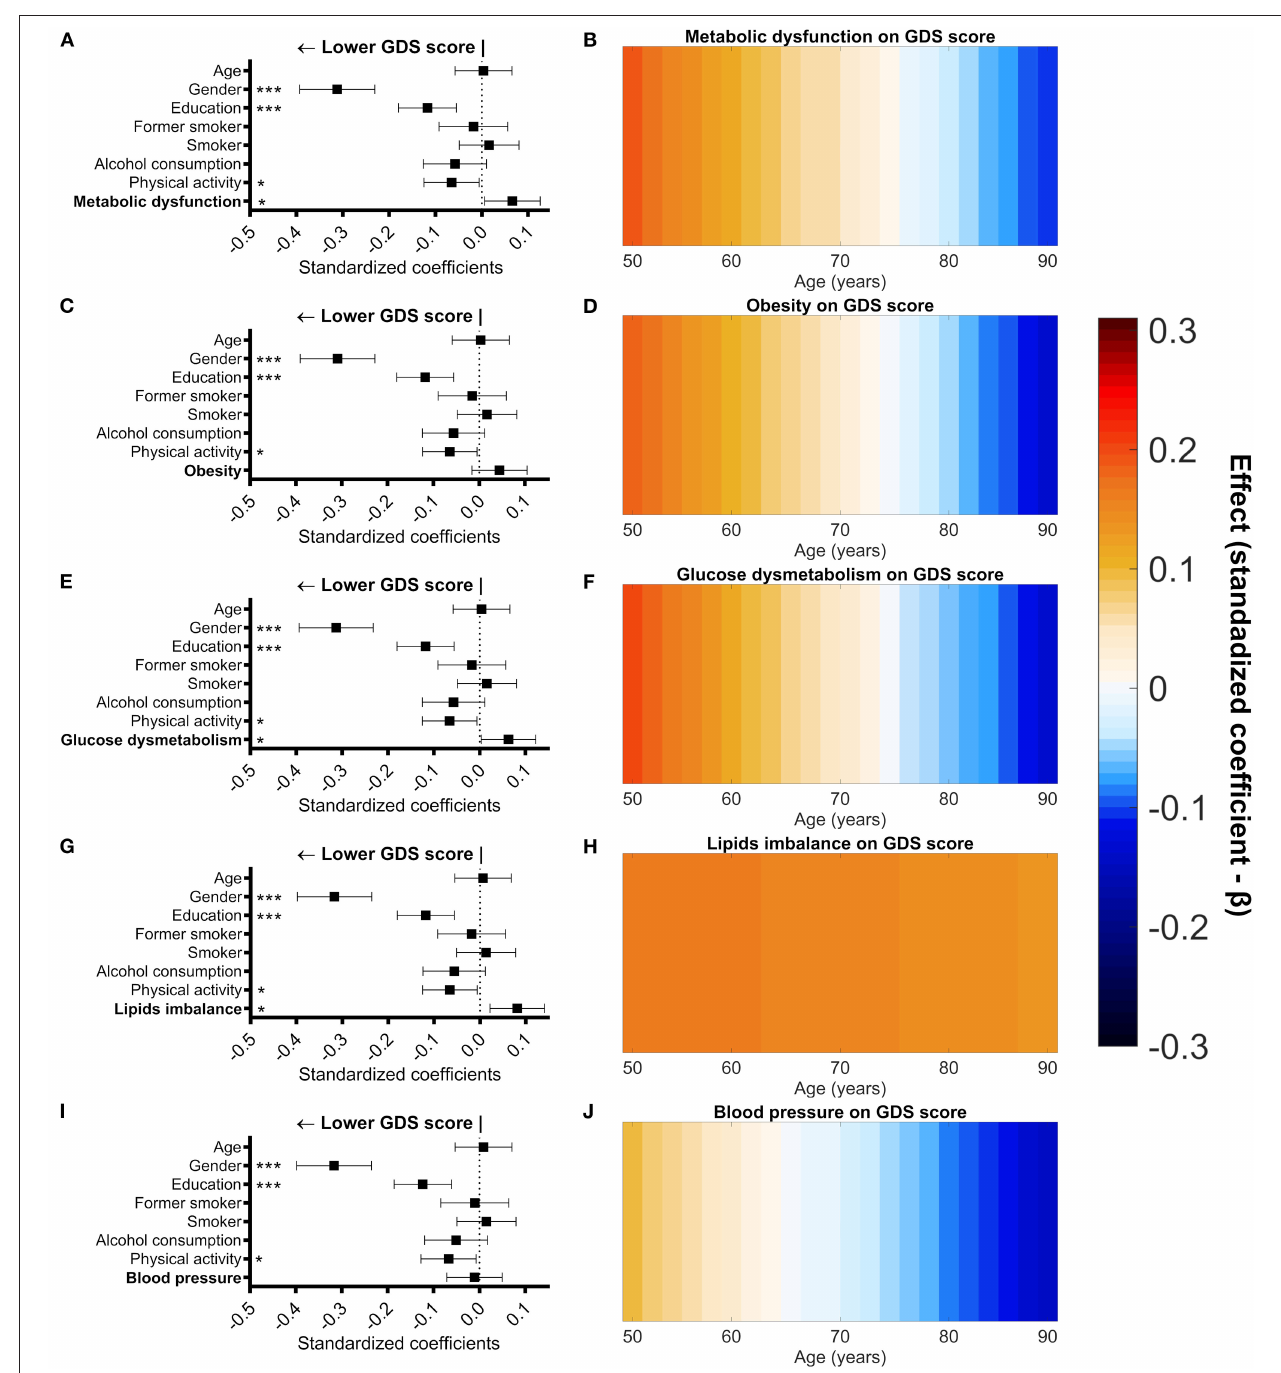
FIGURE 3 | Association of metabolic dysfunction (and components) with GDS score controlled for age, gender, education, smoking status, alcohol consumption, and physical activity. Graphical representation of standardized coefficients (standardized beta) and respective confidence intervals for the independent variables used in the multiple regression linear models (A,C,E,G,I) . Male gender, higher formal education (measured in school years), higher physical activity, and lower metabolic dysfunction score were significantly associated with a lower score in the GDS (A) . Male gender, higher formal education, and higher physical activity were significantly associated with a lower score in the GDS (C,I) . Male gender, higher formal education, higher physical activity, and lower glucose dysmetabolism score were significantly associated with a lower score in the GDS (E) . Male gender, higher formal education (measured in school years), higher physical activity, and lower lipids imbalance score were significantly associated with a lower score in the GDS (G) . Graphical representation (heat maps) of the variation of standardized coefficients (standardized beta) for the association between metabolic dysfunction (and components) with GDS score across age (B,D,F,H,J) . Warm colors represent a